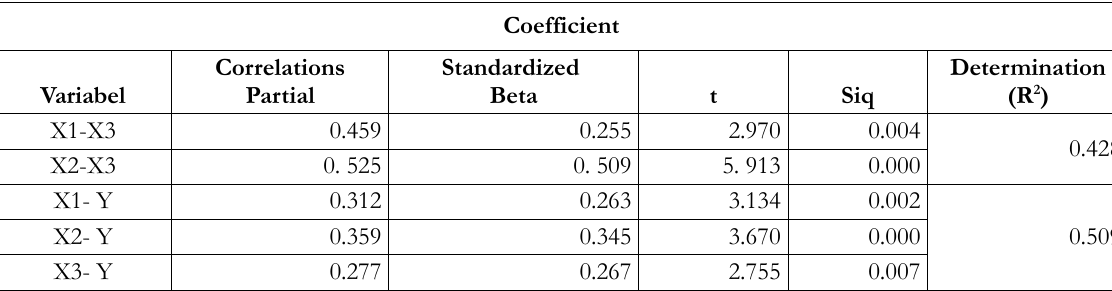
Table 6. Coefficients standardized beta and factor of